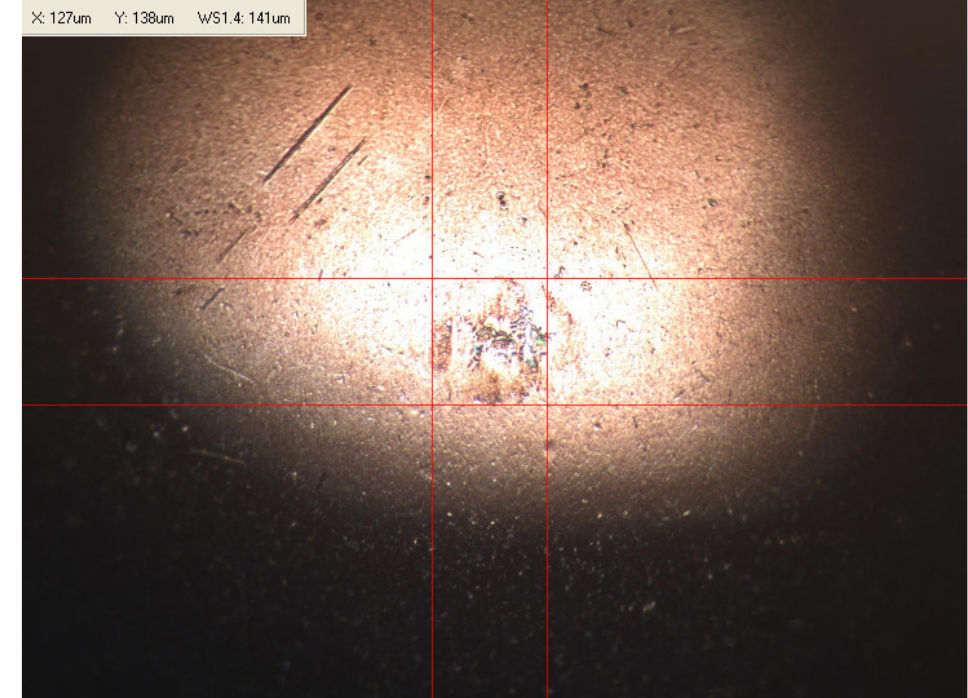
Figure A12. SAE 40—90% m/m; DO—10% m/m.